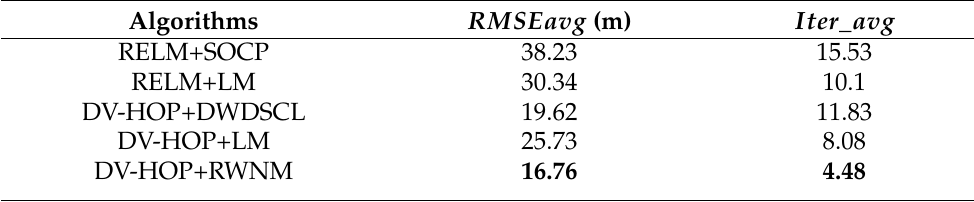
Figure 9. ( a ) RMSEavg and ( b ) Iter _ avg after running five iterative algorithms over 10 multi-hop anisotropic networks with R = 35 m and nfe = 0.3. Outliers levels are increased by steps of 10% from 0% to 50%. Table 7. RMSEavg and Iter _ avg at different levels of outliers Θ from 0% to 50%, R = 35 m and nfe = 0.3 under anisotropic networks, the best performances in RMSE average and iteration average are denoted in bold